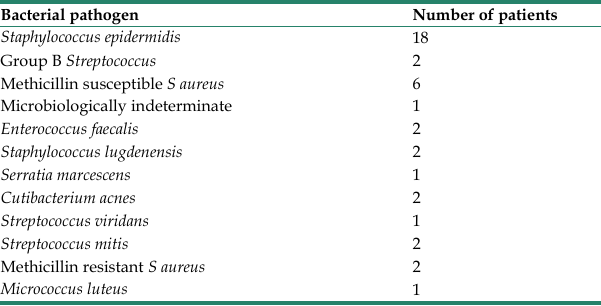
Table 3. Microbiological Findings of 41 Patients With Bacterial PJIs (Controls) Seen at Center A and Center B Between 2010 and 2016 Bacterial pathogen Number of patients Staphylococcus